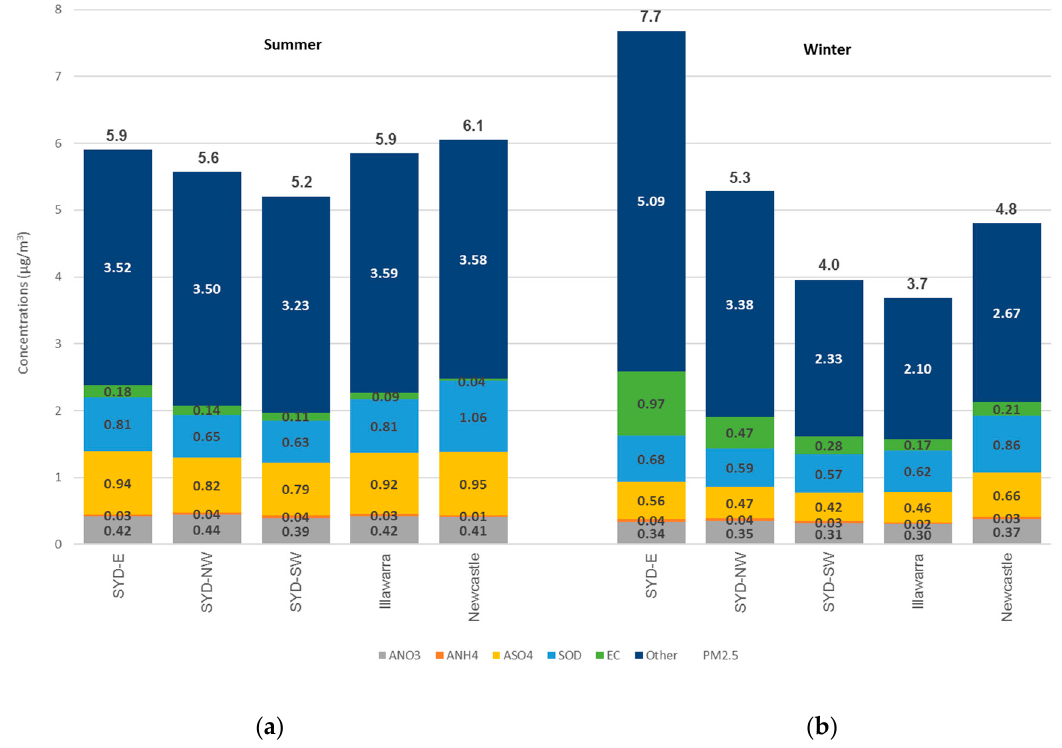
Figure 5. Regional average concentrations of total PM 2.5 (values shown on top of each stacked column), particulate nitrate (ANO3), ammonium (ANH4), sulphate (ASO4), sodium (SOD), elemental carbon (EC) and other species in the Sydney east (SYD-E), Sydney Northwest (SYD-NW), Sydney Southwest (SYD-SW), Illawarra and Newcastle regions for ( a ) summer and ( b ) winter in 2008.